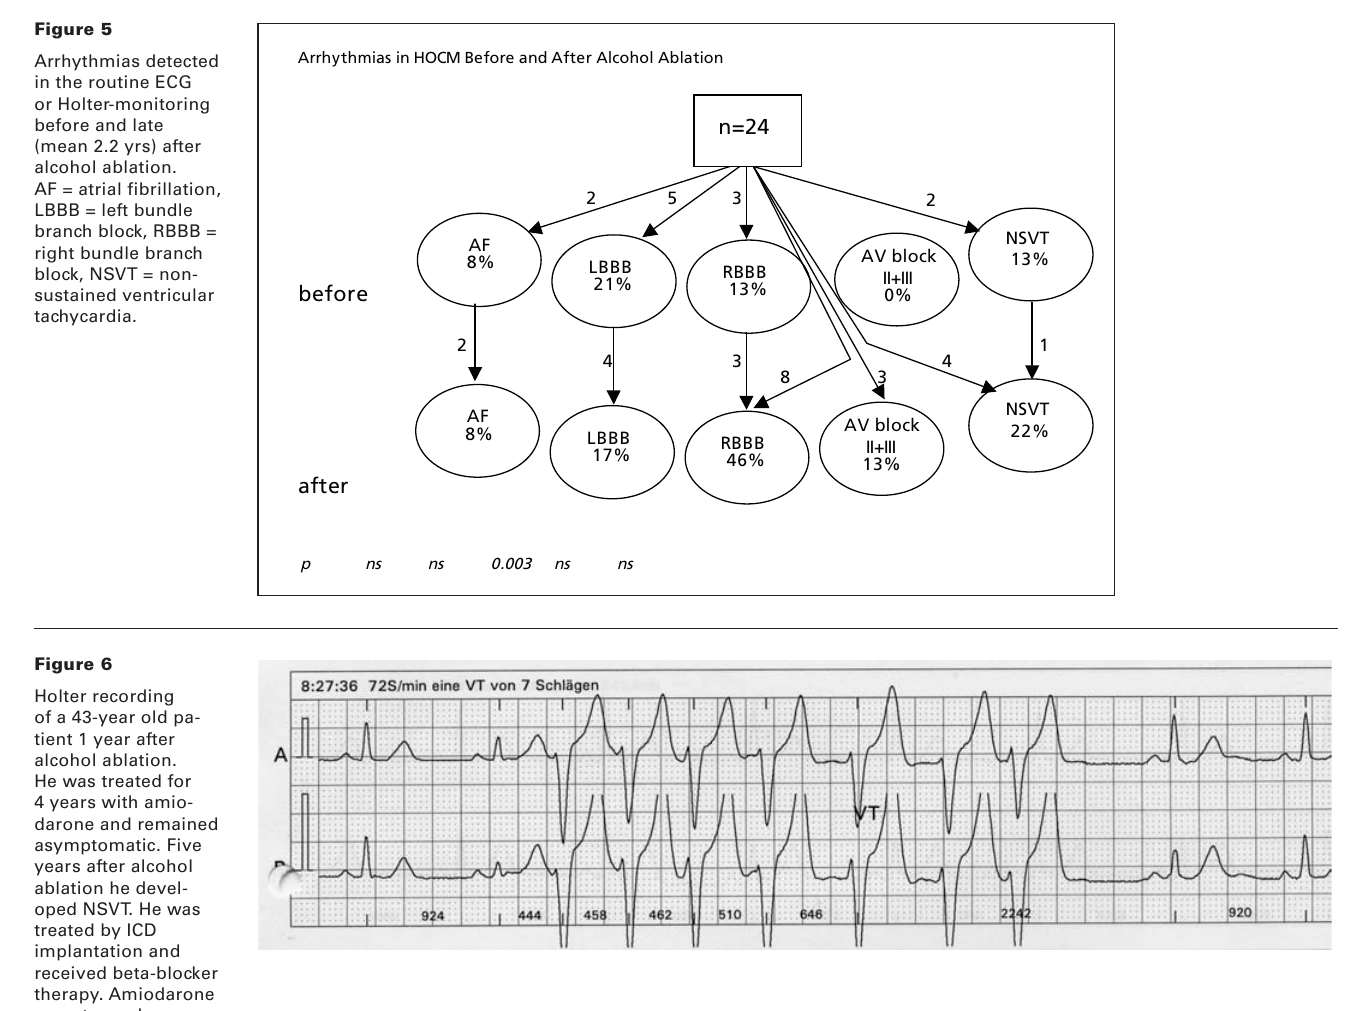
Arrhythmias detected in the routine eCG or Holter-monitoring before and late (mean 2.2 yrs) after alcohol ablation. AF = atrial fibrillation, lBBB = left bundle branch block, RBBB = right bundle branch block, NSVT = non- sustained ventricular